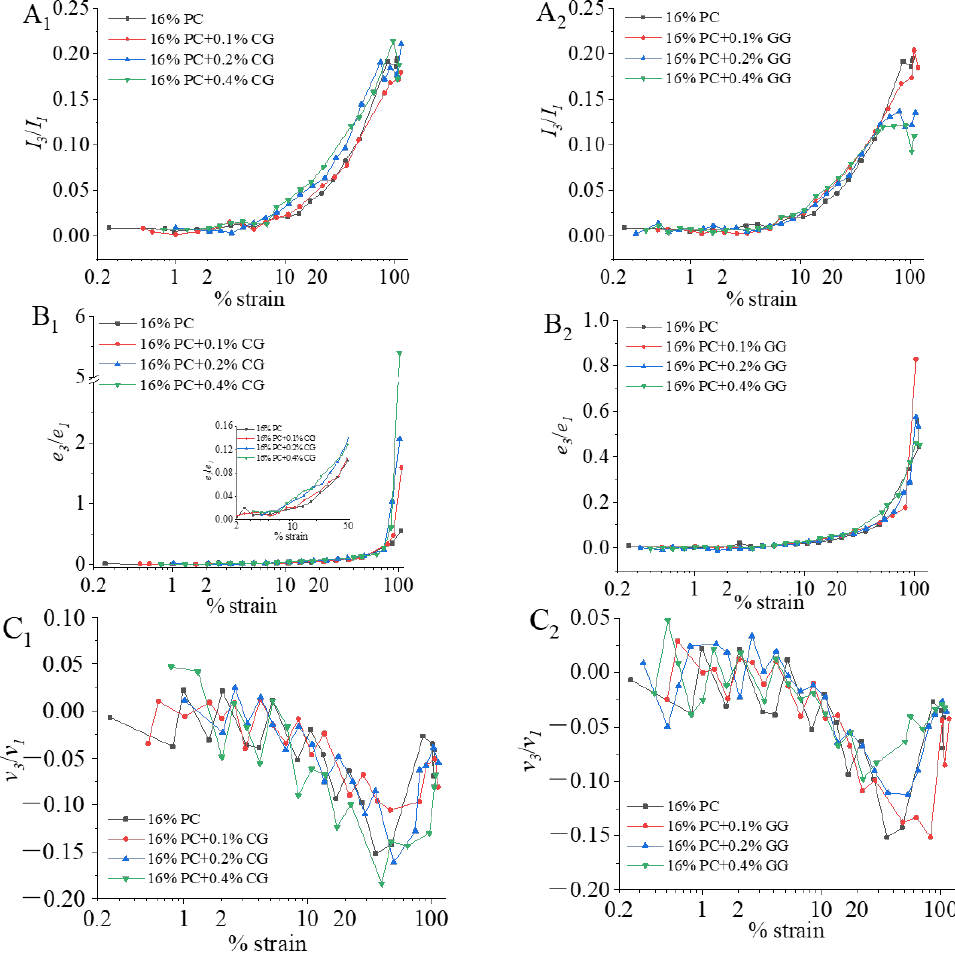
Figure 3. The effect of addition of κ -carrageenan (CG) on I 3 / I 1 ( A 1 ), e 3 / e 1 ( B 1 ), and v 3 / v 1 ( C 1 ) as a function of strain amplitude for the phycocyanin gel (PC); The effect of addition of guar gum (GG) on I 3 / I 1 ( A 2 ), e 3 / e 1 ( B 2 ), and v 3 / v 1 ( C 2 ) as a function of strain amplitude for the phycocyanin gel (PC).